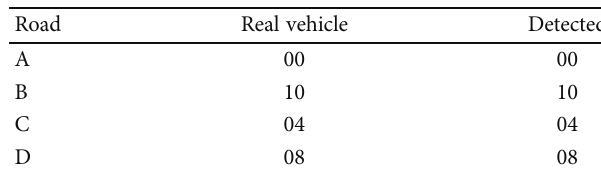
Table 2: Vehicle detection and counting using IoT sensors and